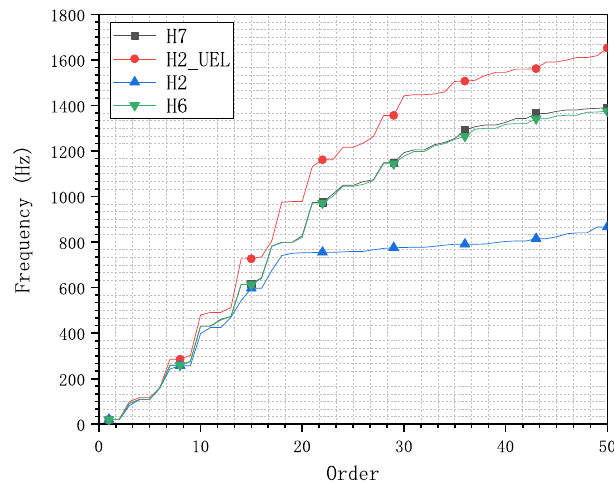
Figure 16. Frequency comparison of the C3D8 and UEL for mesh model H2.